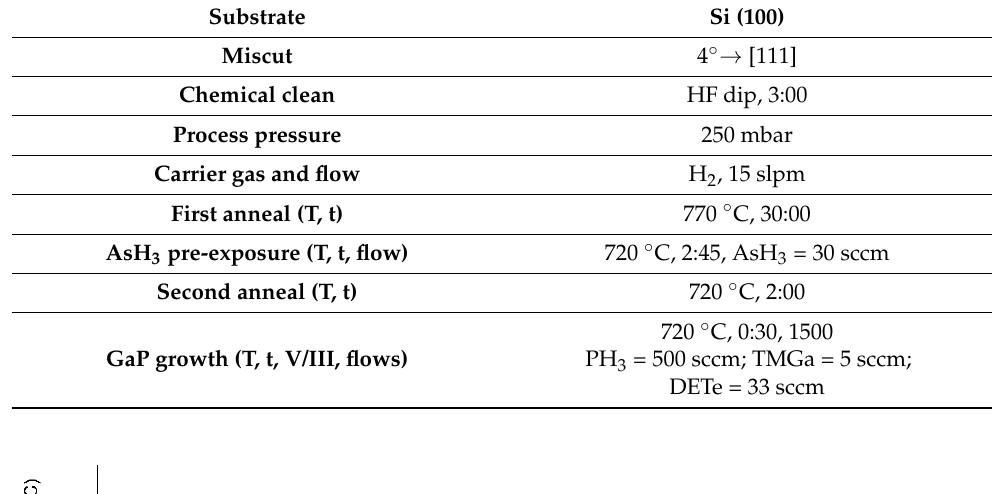
Table 1. Summary of the process variables of our GaP/Si nucleation routine. All times are indicated with format mm:ss (minutes:seconds); slpm stands for standard litters per minute; sccm stands for standard cubic centimeters per minute.